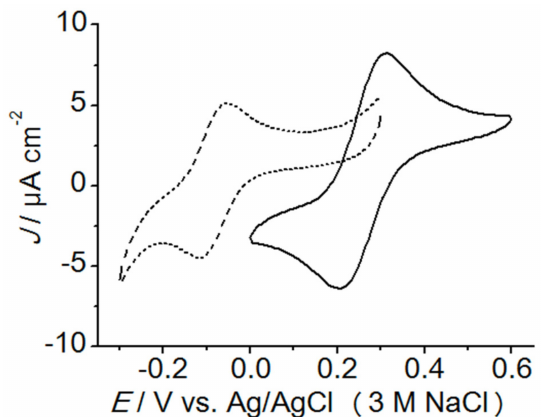
Figure 5. Cyclic voltammograms of the glassy carbon electrode in 50 mM CHES (pH = 9.0) containing 30 mM ethylamine with PGA-AmFc (solid line) and 0.5 mM AmFc (dotted line). The voltammograms